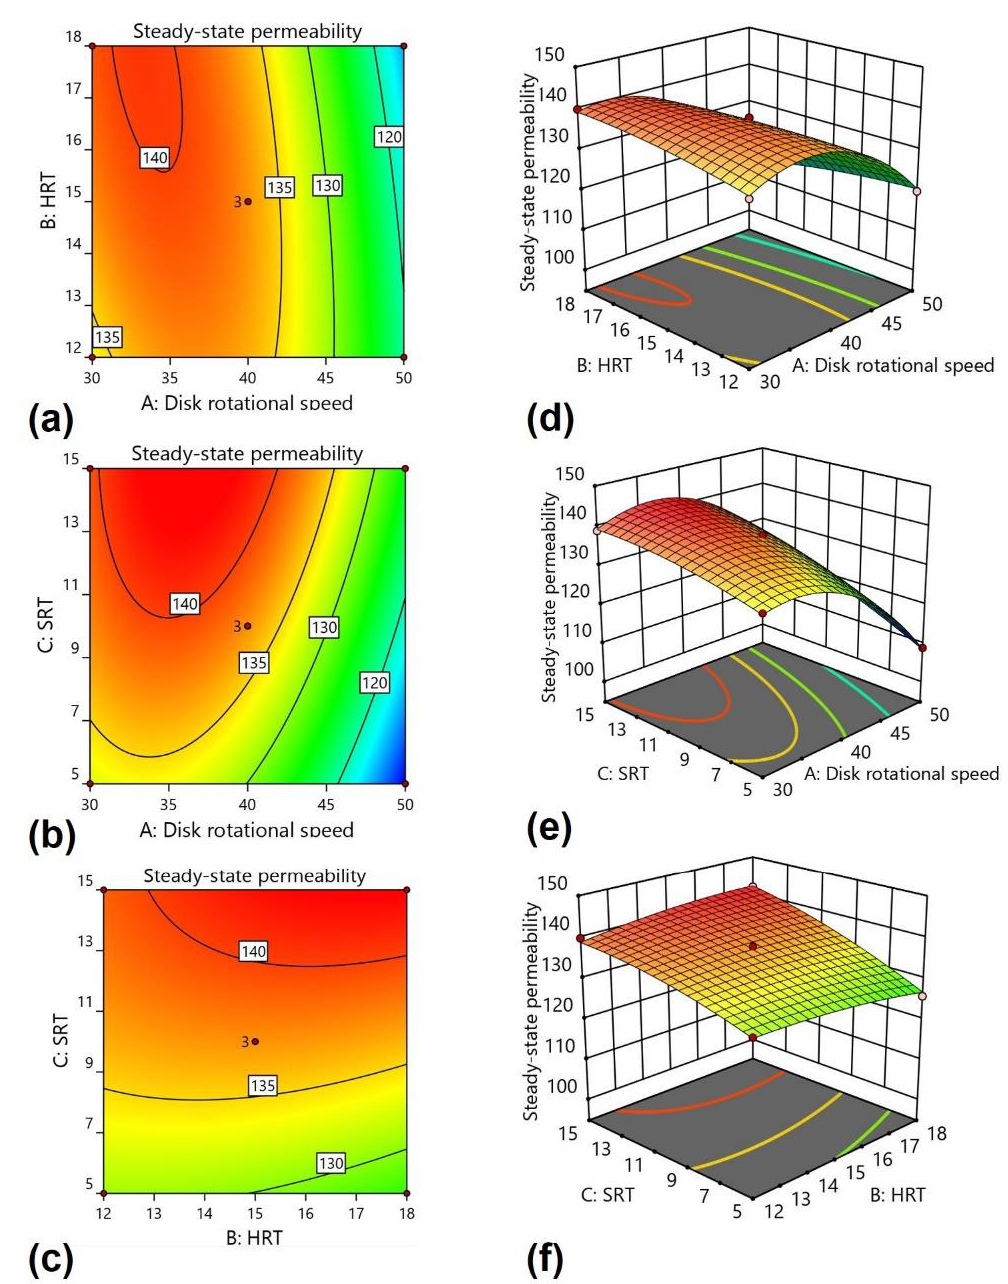
Figure 3. Effect of 2-D contour of ( a ) disk rotational speed and HRT, ( b ) disk rotational speed and SRT, ( c ) HRT, and SRT, and 3-D response surface plots of ( d ) disk rotational speed and HRT, ( e ) disk rotational speed and SRT, and ( f ) HRT and SRT.